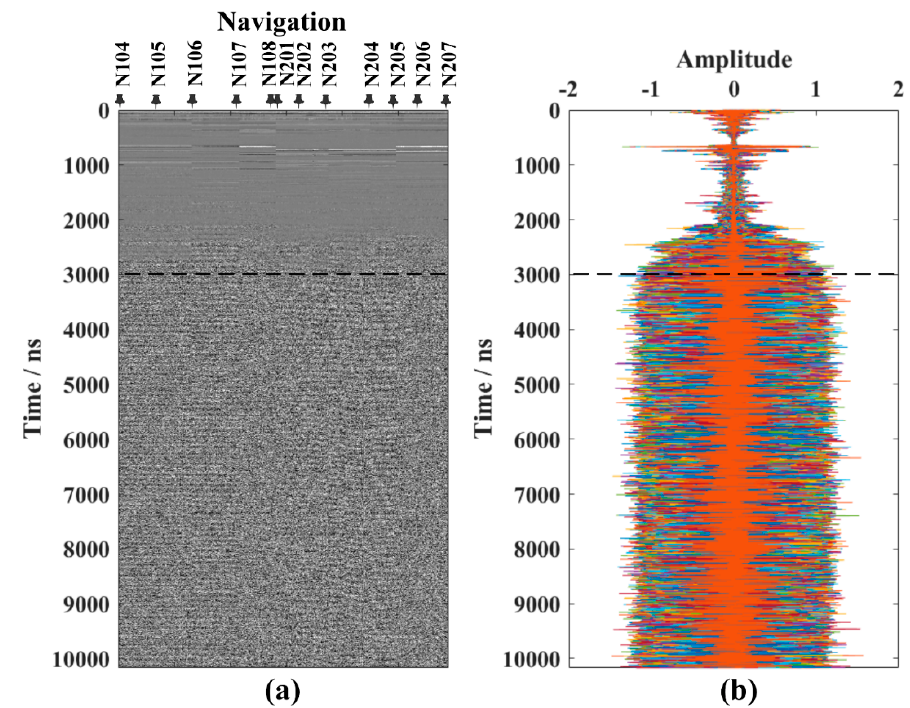
Figure 12. ( a ) Superimposed component of IMF3 and IMF4 and ( b ) all the traces.